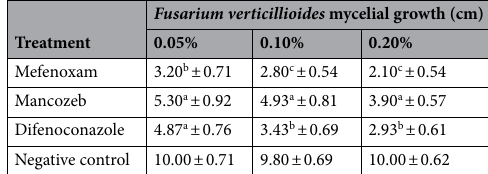
Table 3. Antifungal activity of synthetic fungicides against Fusarium verticillioides. Percentage values are concentrations of the fungicides tested. Data represent mean ± standard deviation (SD) of three replicates . All mean values in the same column with different letters are significantly different from each other (P < 0.05). Negative control: sterile distilled water.